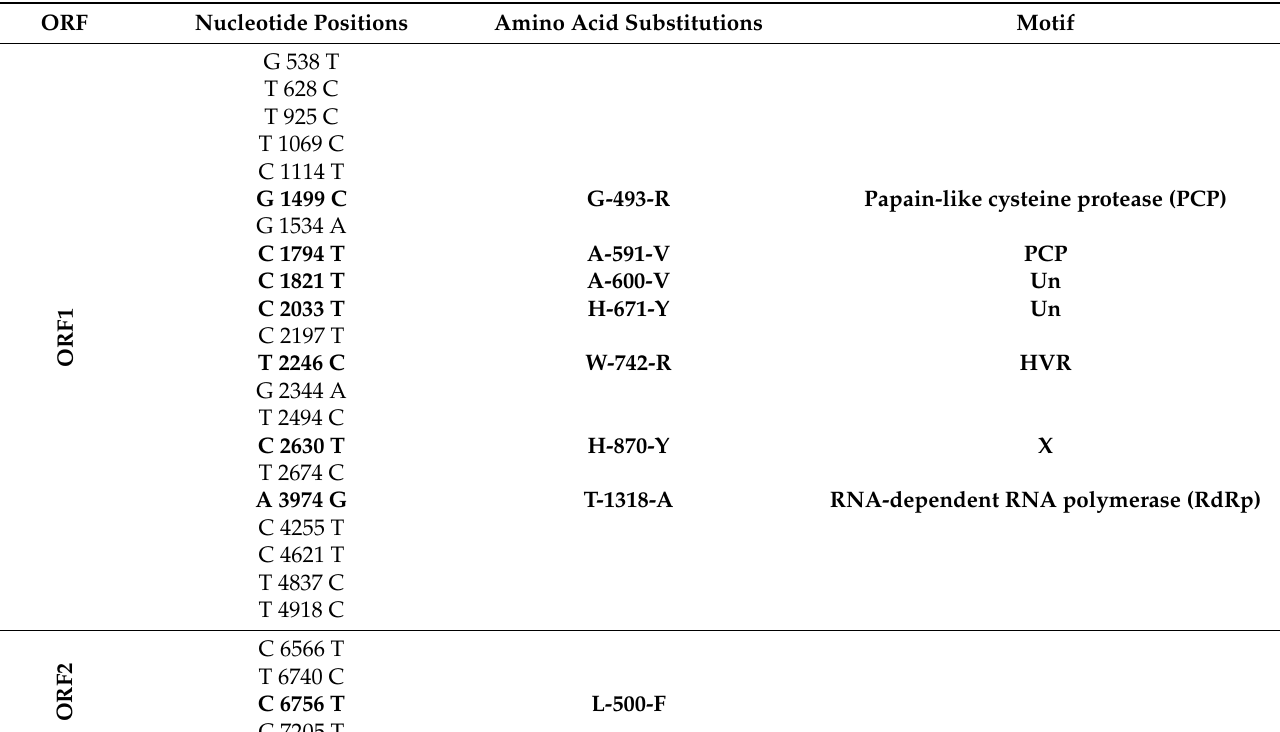
Table 2. Nucleotide mutations and amino acid substitutions of HEV virus HEV3f-P7H recovered at passage 7 in comparison to initial strain JN906974. Nucleotide positions are indicated with JN906974 base left and HEV3f-P7H base right. Amino acid (aa) substitutions and positions are indicated with JN906974 aa left and HEV3f-P7H aa right. ORF and putative motifs within ORF1 are indicated for each substitution. ORF1 unclassified region (Un) corresponds to the region between the PCP and HVR domains. Non-synonymous mutations are in bold. HEV3f-P7H Genebank accession # MW383253. ORF Nucleotide Positions Amino Acid Substitutions